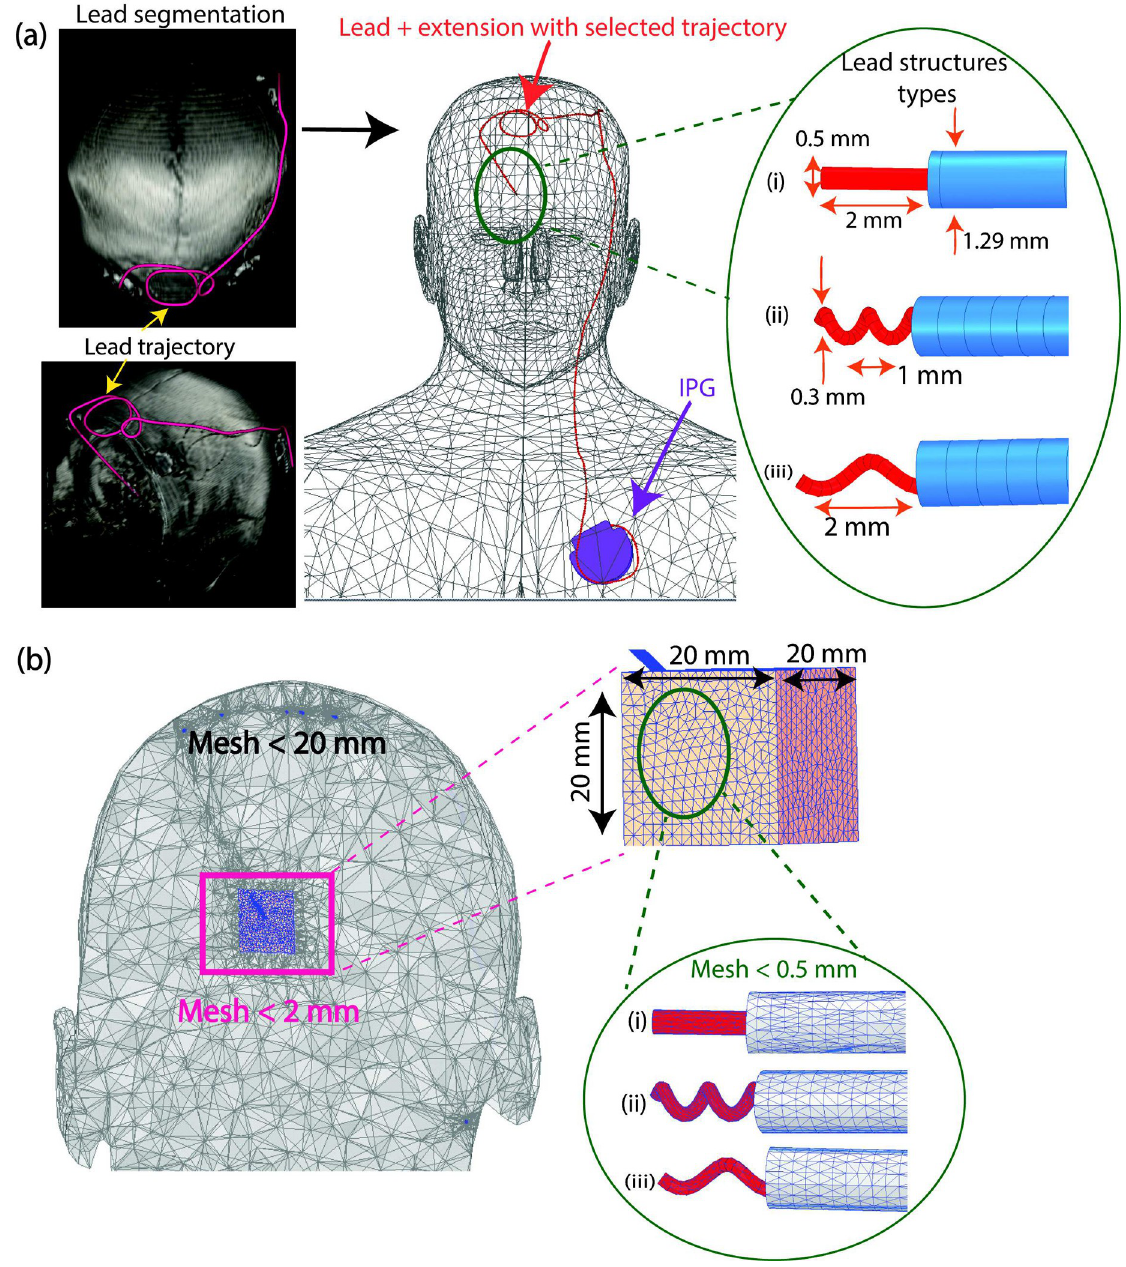
Fig 3. DBS system modeling and simulation setup. (a) Segmentation of an example DBS lead trajectory (magenta) from the lead artifact displayed in the 3D surface rendered view of a patient’s computed tomography image and reconstruction of a full DBS model oriented in a homogeneous body model truncated at the abdomen. Reconstructed DBS lead models of the same trajectory (Pt-Ir core wire (red) within a urethane insulation (blue)) with various internal geometries were evaluated: (i) straight wire, (ii) helical wire with a 1 mm pitch, and (iii) helical wire with a 2 mm pitch. (b) Example mesh distributions of the body, tissue region for specific absorption rate (SAR) calculations, and the